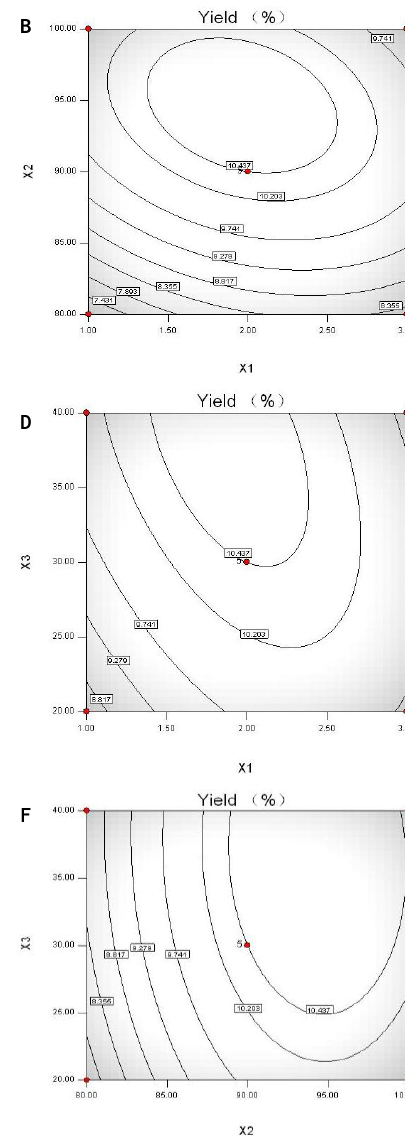
), extraction temperature ( X ), and ratio of water 1 2 ), and the effect of their their reciprocal 3